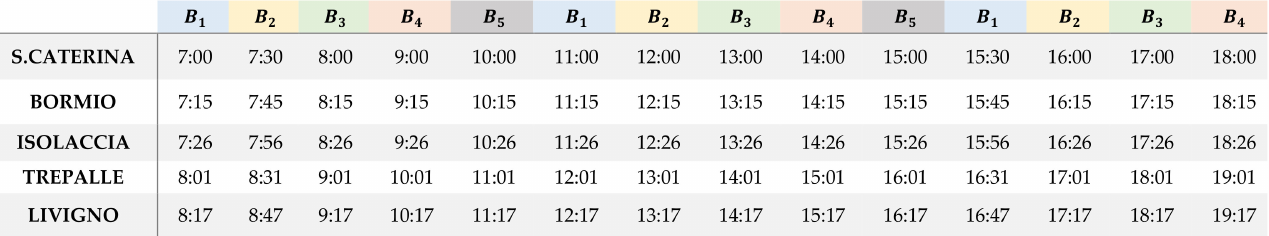
Figure 10. High season Outward.